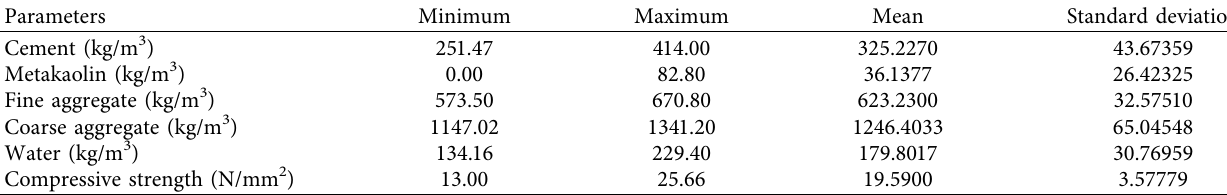
Table 3: Descriptive statistics of the dataset.